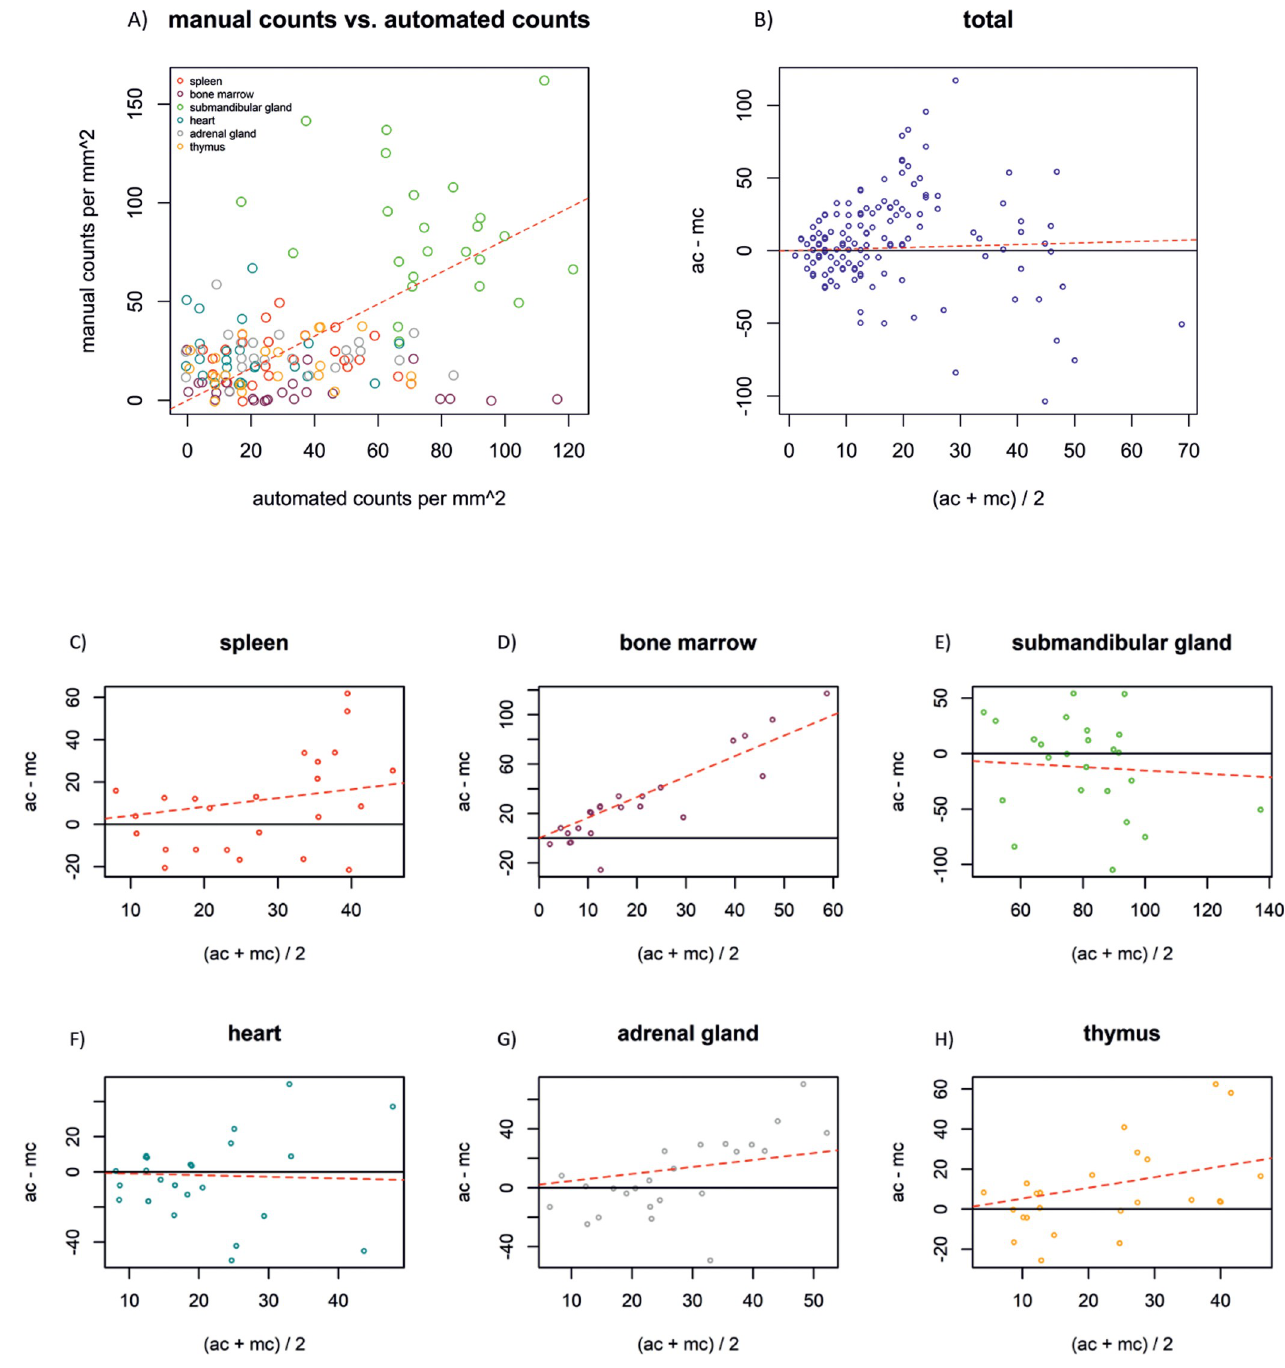
Fig 3. Scatter plot and Bland–Altman plots of manual count values vs. automated count values per image overall and in each individual tissue. A) The regression line of the scatter plot has a slope of 0.81 (red dotted line), illustrating higher fiber counts per image with the automated method compared to the manual approach. B) the Bland–Altman plot shows that automated counts (ac) were higher than manual counts (mc) overall. Slope of the regression line is 0.10 (red dotted line). C) automated counts (ac) are higher than manual counts (mc) in spleen. The slope of the regression line is 0.41 (red dotted line). D) ac are higher than mc in bone marrow. The slope of the regression line is 1.66 (red dotted line). E) ac are lower than mc in submandibular gland. The regression line has a slope of -0.15 (red dotted line). F) In heart sections ac are lower than mc. The regression line has a slope of -0.09 (red dotted line). G) ac are higher than mc in adrenal gland sections. The regression line has a slope of 0.47 (red dotted line). H) In thymus sections, ac are higher than mc illustrated by a regression line with a slope of 0.53 (red dotted line).